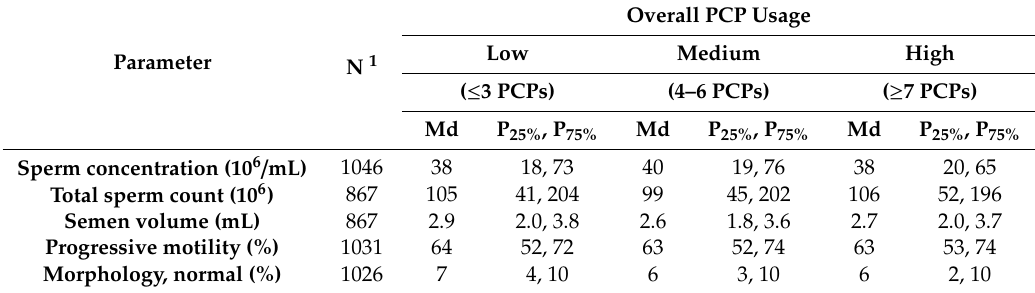
Table 4. Semen characteristics for the 1046 men in the FEPOS cohort stratified by aggregated PCP usage.